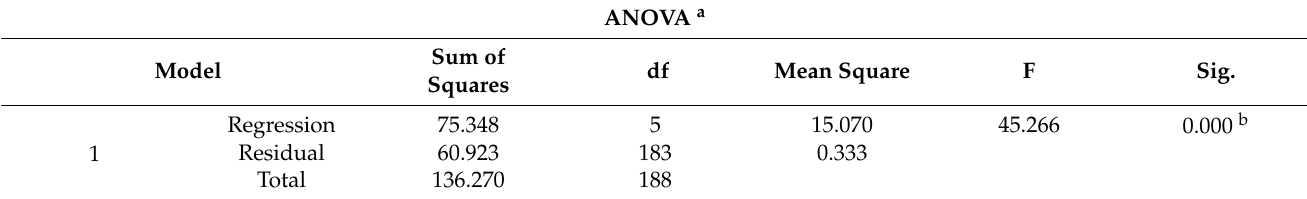
Table 13. ANOVA results.